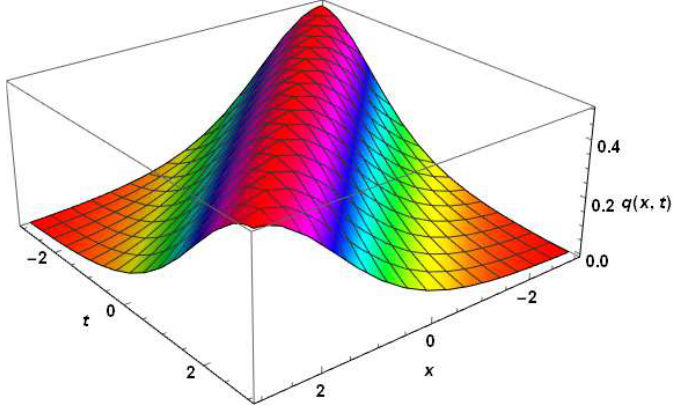
(cid:2869) (cid:2869) . . . Figure 1. The surface plot of a bright 1-soliton (2) for 𝑛 = (cid:2870) (cid:2870) 2